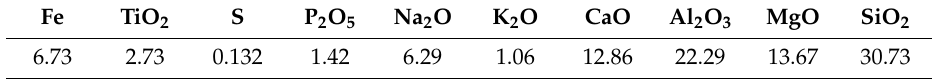
Table 1. Main chemical composition analysis of the P–Containing V–Ti magnetite tailings (%).